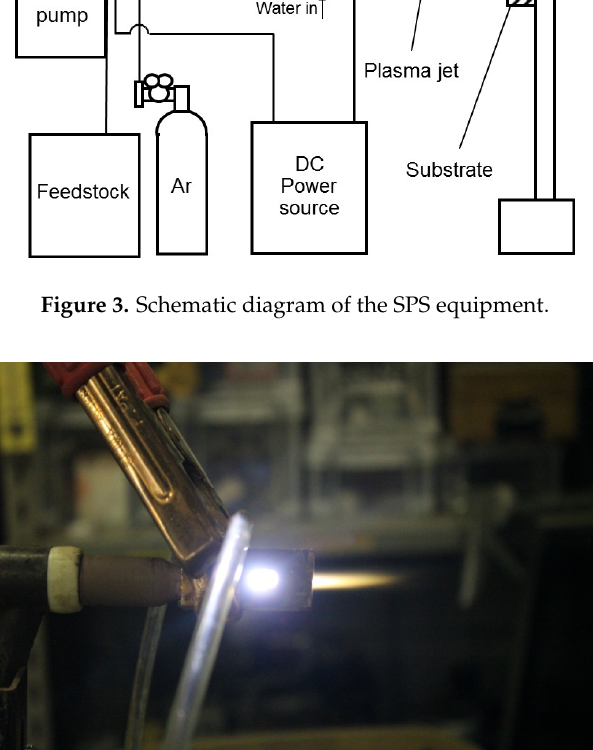
Figure 4. Plasma jet generated by our thermal spray equipment.